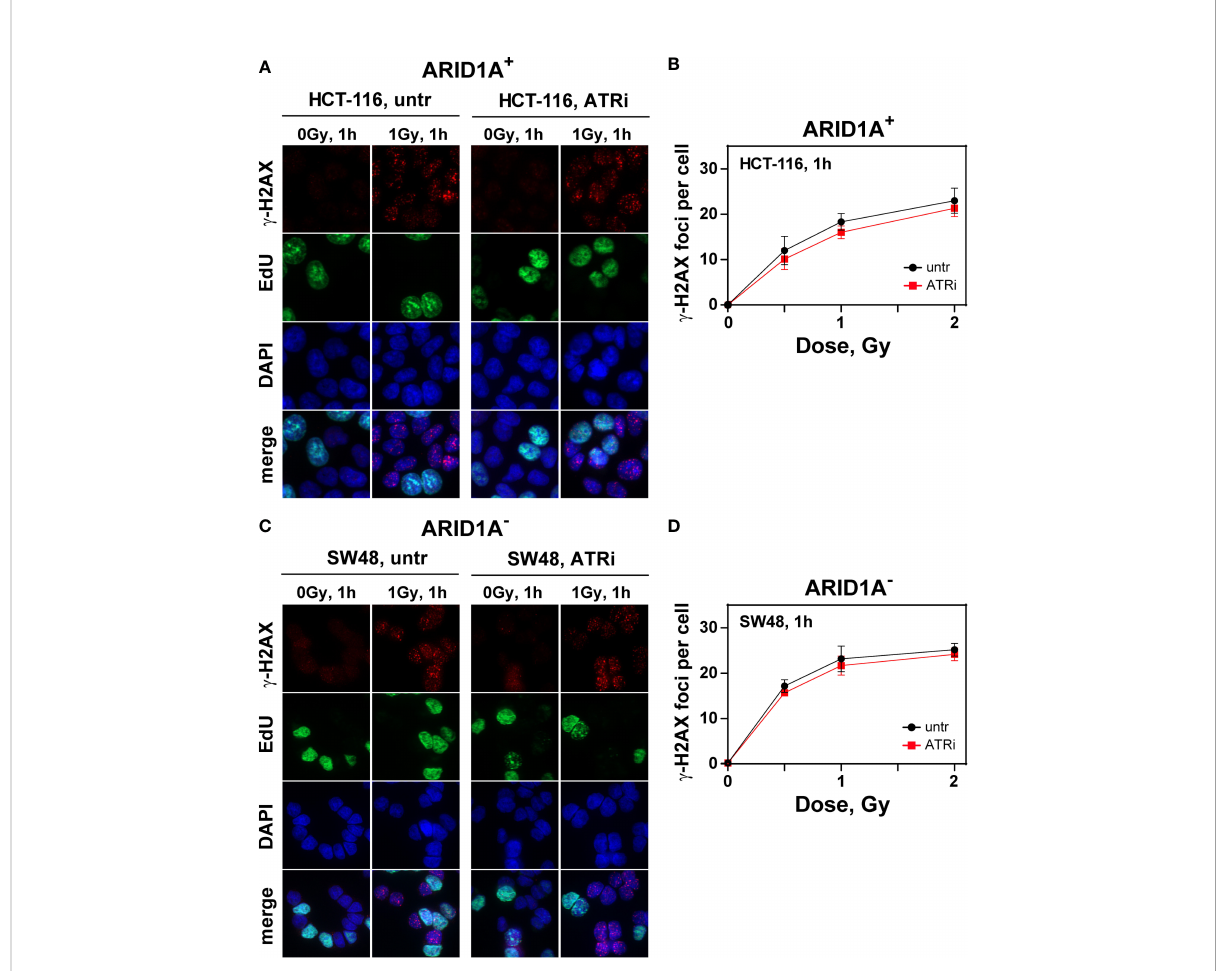
FIGURE 3 Effect of ATRi on ɣ H2AX foci formation in G2-phase CRC cell lines.Maximum intensity projection (MIP) images of g H2AX foci (red) at tmax (1h) in G2-phase ARID1A + (A, B) and ARID1A - (C, D) cells without (untr) and with 20 nM VE822 (ATRi) in EdU - (green) cells after exposure to the indicated IR doses. Cells were counterstained with DAPI (blue). The respective numbers of g H2AX foci at tmax as a function of IR dose are shown in (B) (ARID1A + cells) and (D) (ARID1A - cells). Results of 3 independent experiments are shown for CRC cell